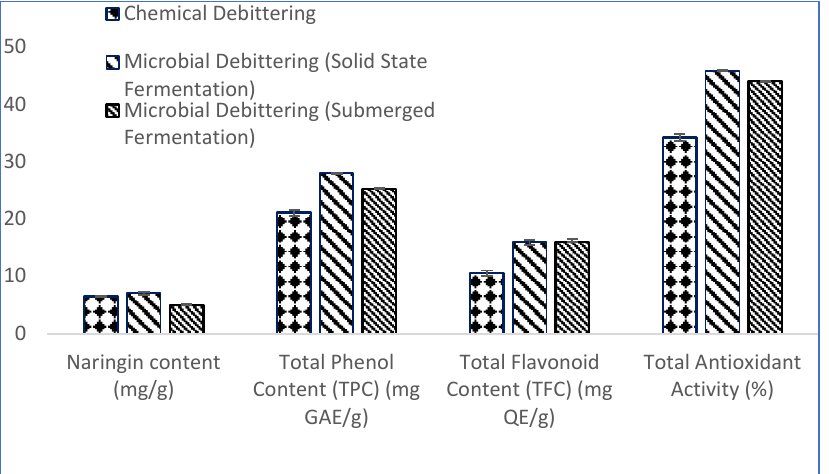
Figure 1. Naringin and bioactive components obtained from chemical and microbial methods.